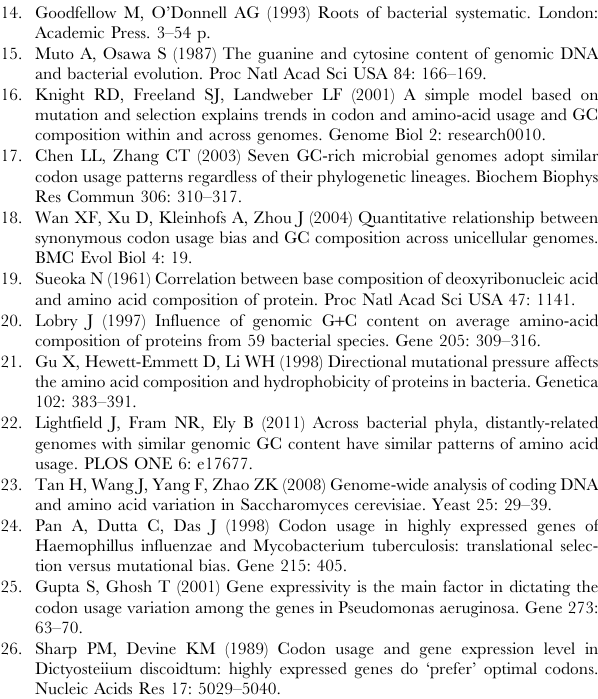
Table S1 Genomic length and GC content of all samples included in the analyses. Table S2 Mean usage frequencies of base A, T, C, and G at the first, second, and third codon positions of all samples included in the analyses. Table S3 Mean usage frequencies of 64 codons of all samples included in the analyses. Table S4 Usage frequencies of 20 amino acids of all samples included in the analyses. Table S5 Number of genomes, mean and variance of the distance for nucleotide frequencies, codon usages and amino acid compositions in each section of Group 1, that is to say, each section corresponds to one phyla. Table S6 Number of genomes, mean and variance of the distance for nucleotide frequencies, codon usages and amino acid compositions in each section of Group 2, that is to say, each section corresponds to one specific G + C